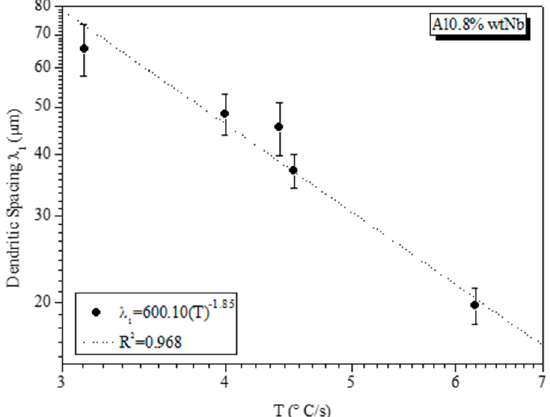
Figure 9. Experimental equations of the secondary dendritic spacing as a function of the metal/mold interface, for alloys Al–0.8%wt Nb and Al–1.2%wt Nb.